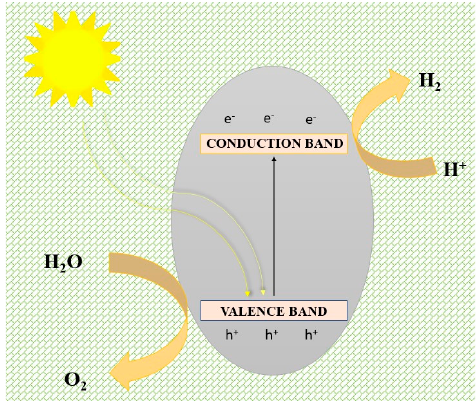
Figure 12. Mechanism of photocatalytic water